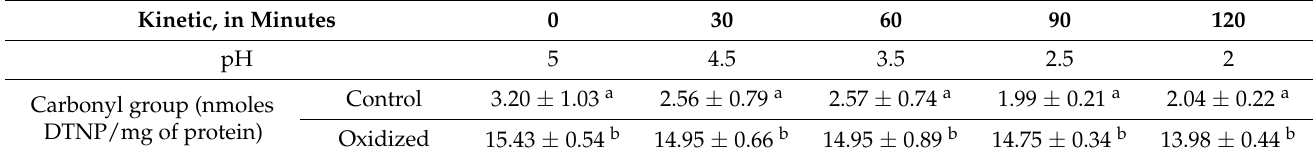
blue) pepsin during the kinetic of gastric acidification, from 0 to 120 min. Table 1. Carbonyl groups content in pepsin and oxidized pepsin during the kinetic of gastric acidification.